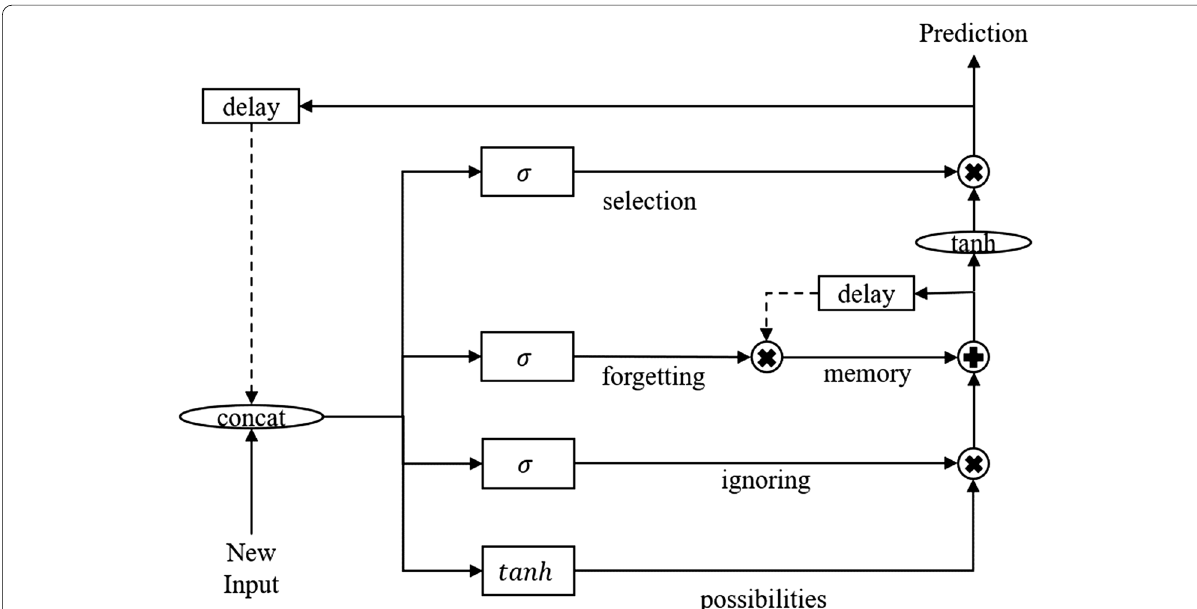
and x connections are +